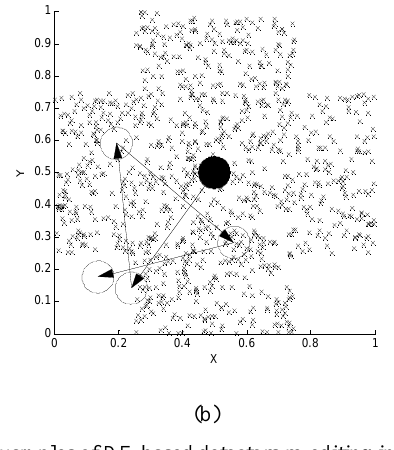
Fig. 4. Examples of DE-based detectors re-editing in NSA (self sample set A).